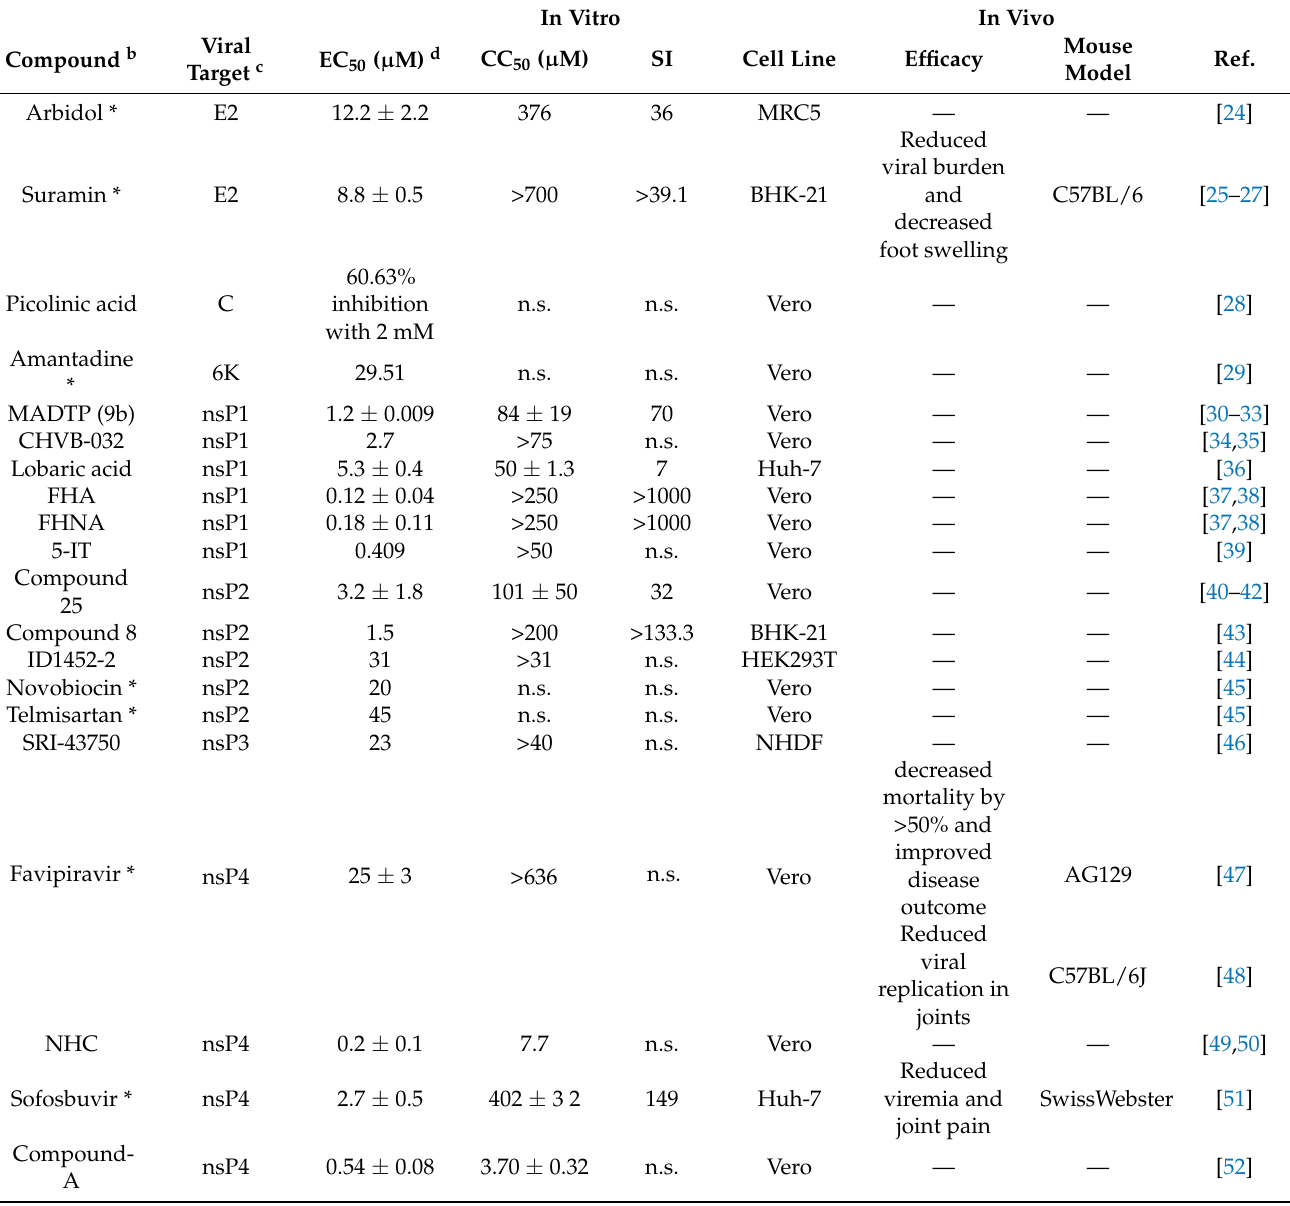
Table 1. Virus targeting compounds a